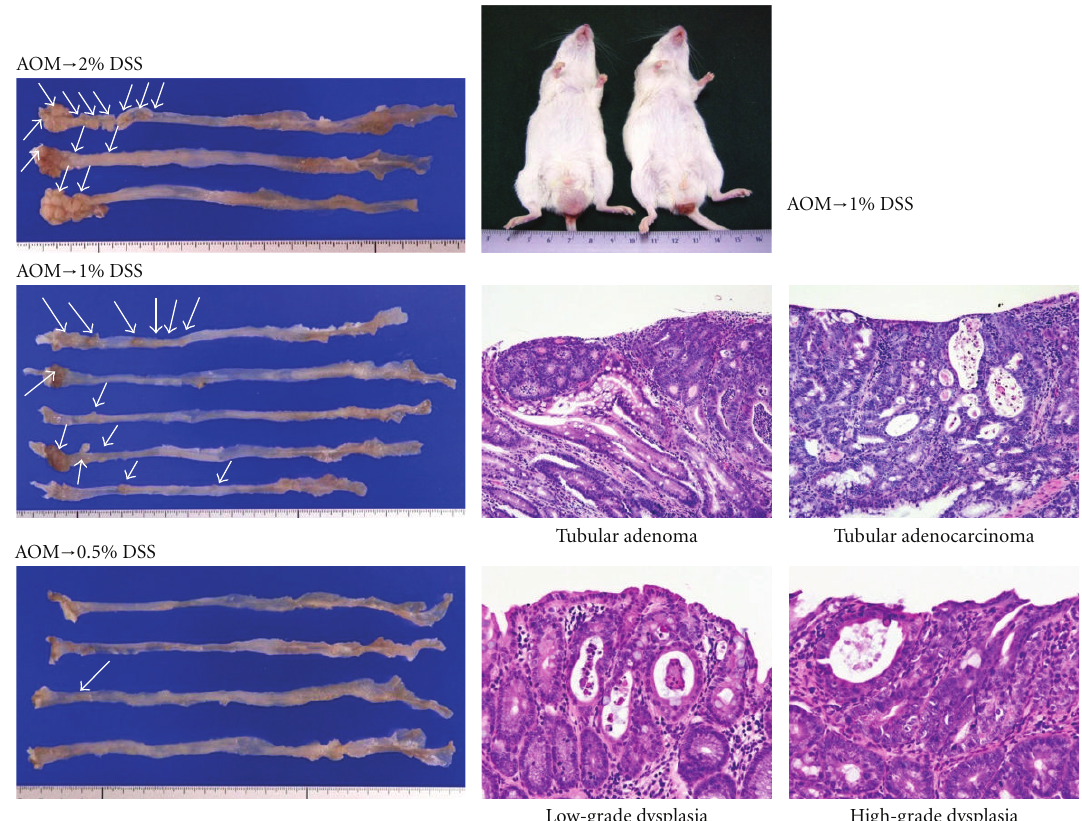
Figure 8: Macroscopic view and histopathology of colonic tumors developed in mice that received AOM and DSS (0.5%, 1%, or 2% DSS in drinking